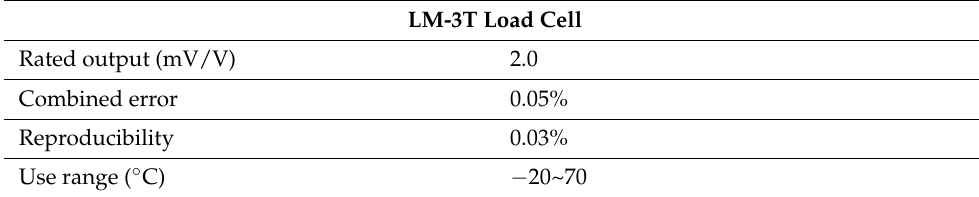
Table 5. Load source specification.